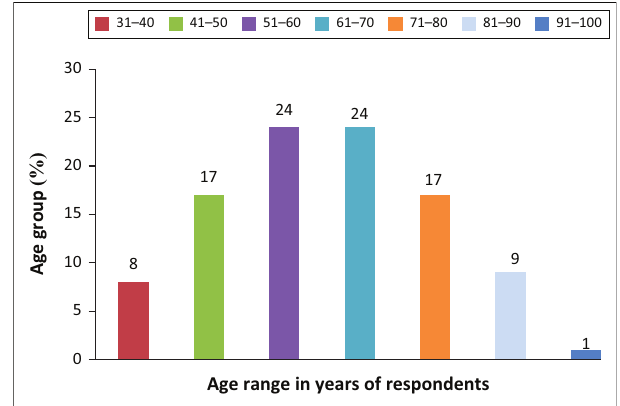
FIGURE 1: Age-specific distribution of